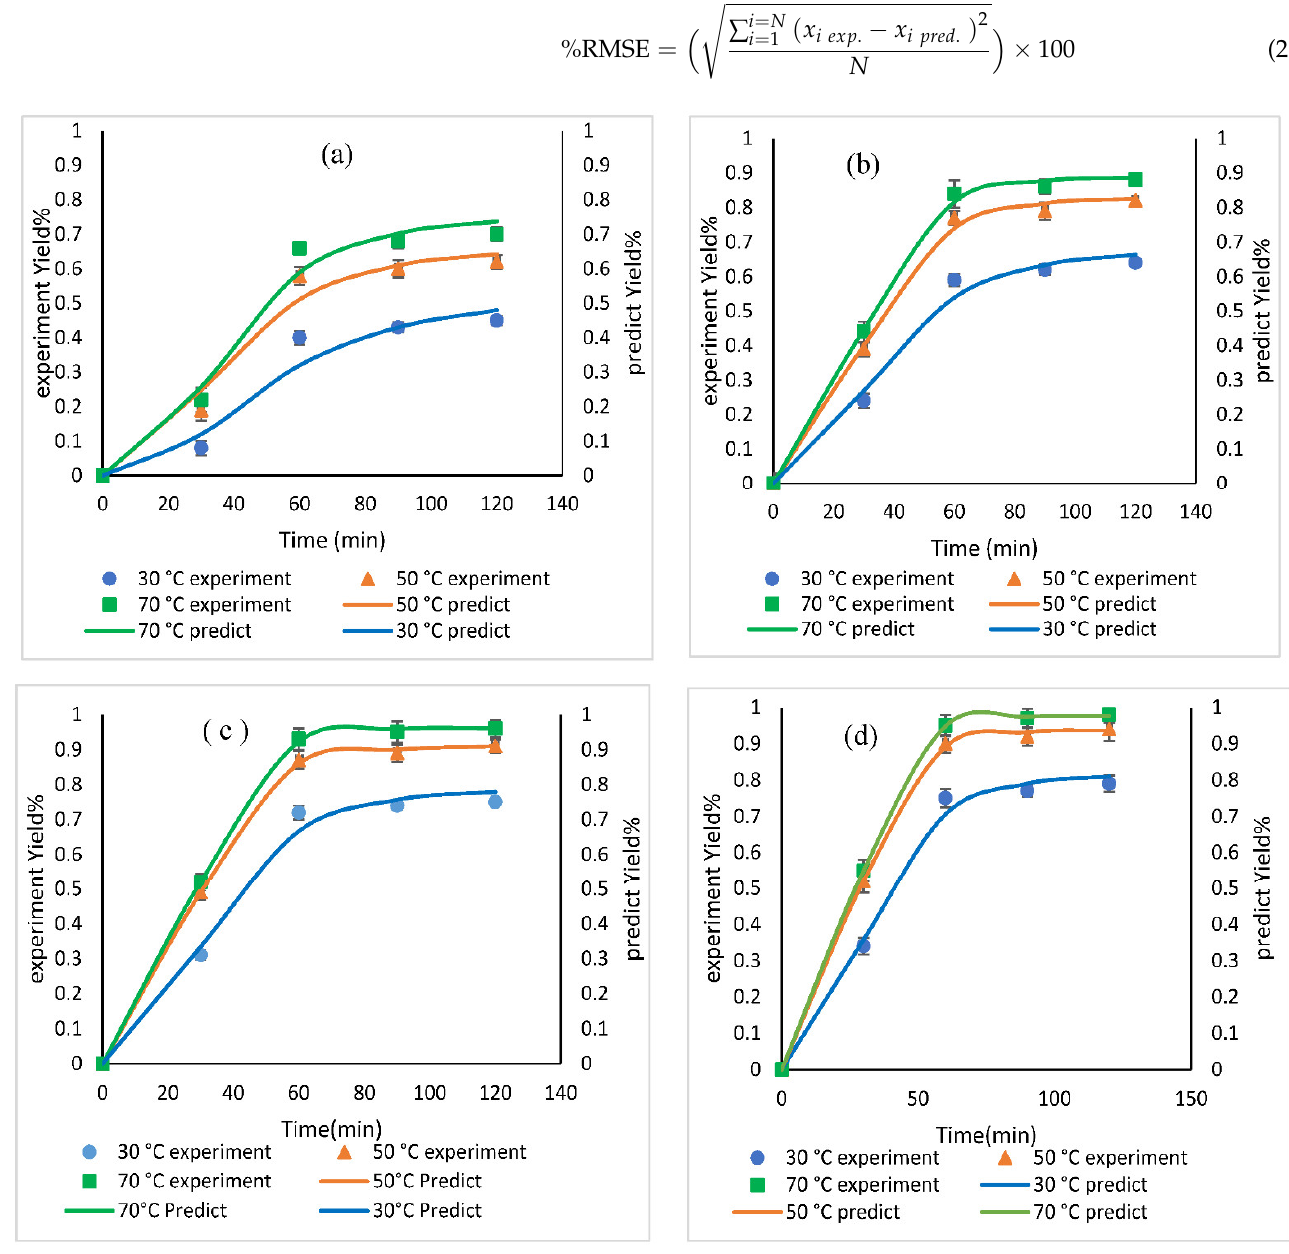
Figure 6. Experimental and mathematical yield% versus reaction times at different reaction tempera- tures for methanol/oil mole ratio: ( a ) 100:1, ( b ) 400:1, ( c ) 700:1 and ( d ) 1000:1. The pseudo first order apparent and actual forward and second order backward rate constants obtained at 100:1 to 1000:1 methanol/oil mole ratio at 30 ◦ C, 50 ◦ C and 70 ◦ C are shown in Table 3. The specific rate constant k f was calculated from Equation (10). It can be seen that the forward rate constants increase with an increase in the reaction temperature, whereas backward rate constants decrease with an increase in the reaction temperature, which is consistent with that reported in the literature.